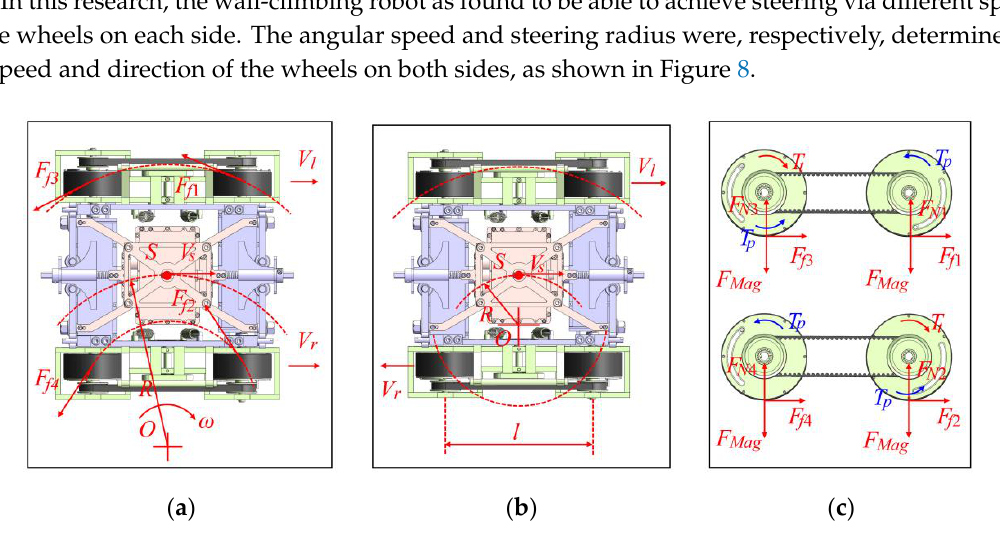
Figure 8. Dynamic analysis in steering: ( a ) Large radius turning state, ( b ) small radius turning state, and ( c ) dynamic analysis of each wheel.